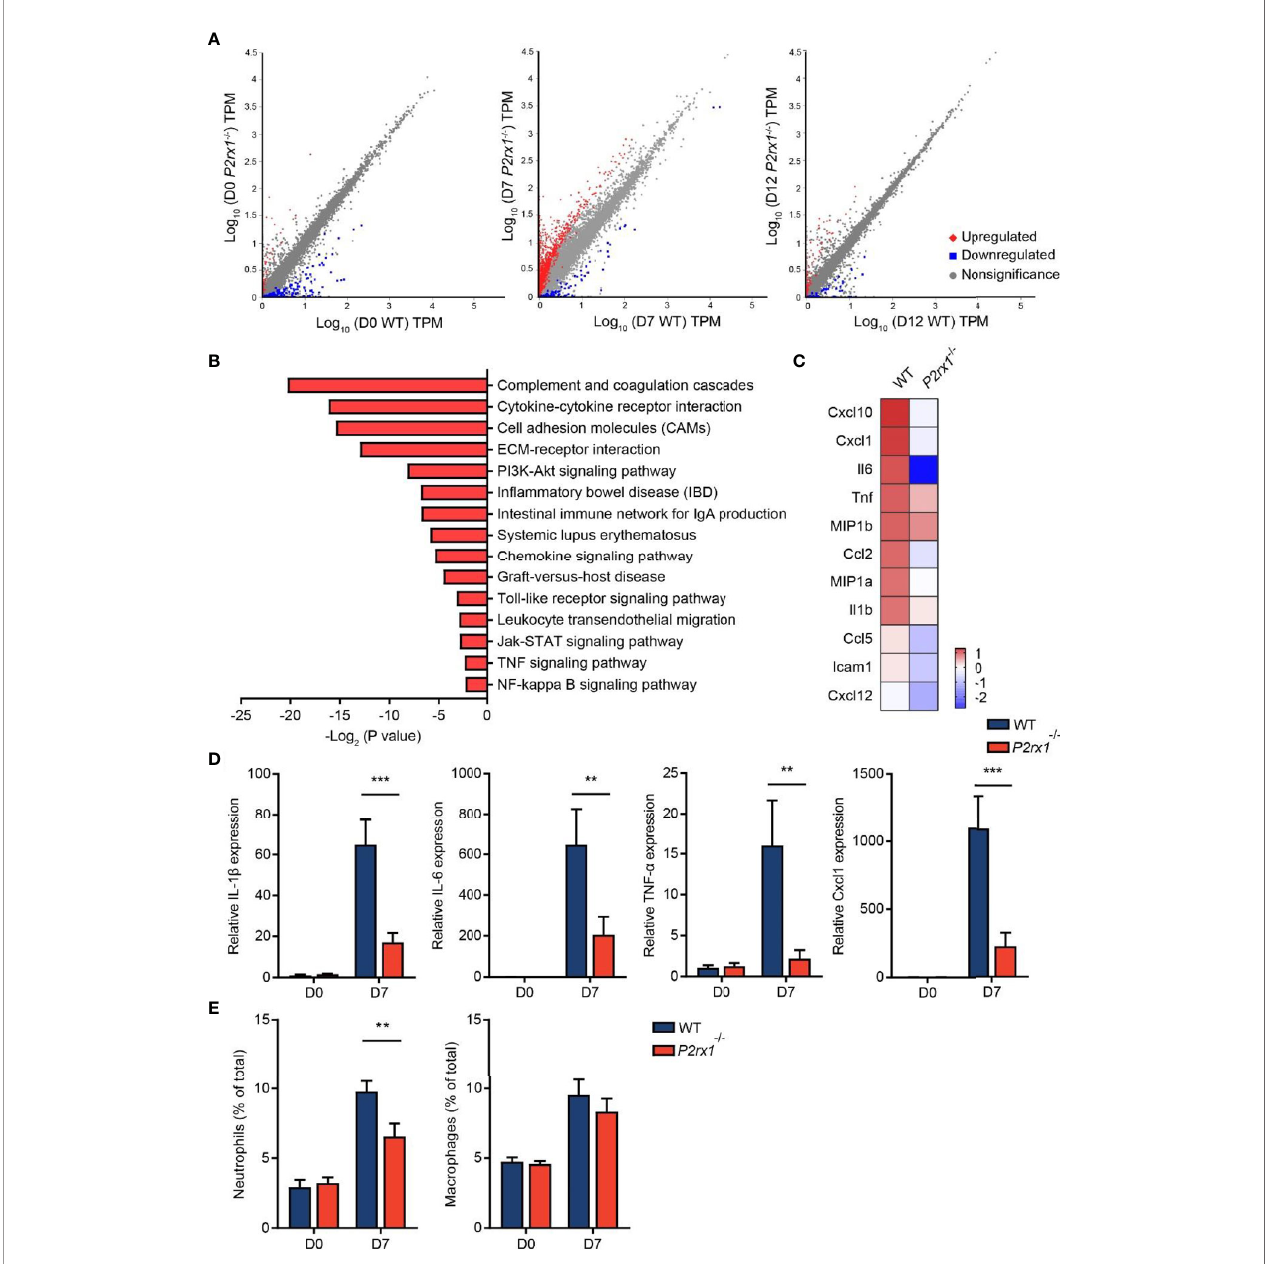
FIGURE 3 | P2RX1 ablation restricts in fl ammatory responses in DSS-induced mouse colitis. (A) WT and P2rx1 − / − mice were treated with 2% DSS for 7 days. At days 0, 7, and 12, colon tissues were harvested, and RNA sequencing was performed. Differential analysis was analyzed, with P <0.001 and fold change >4 being considered as signi fi cantly varied (n = 3 for D0 P2rx1 − / − group, and n = 1 for the rest of the groups). (B) KEGG pathway analysis was performed to compare the functional enrichment genes of WT and P2rx1 − / − mice at day 7. (C) A heatmap of in fl ammation-associated genes was shown. (D) In fl ammation-associated genes were detected by RT-qPCR (n = 4 per group). (E) Neutrophils and macrophages were analyzed by fl ow cytometry (n = 4 per group). **P < 0.01 and ***P <